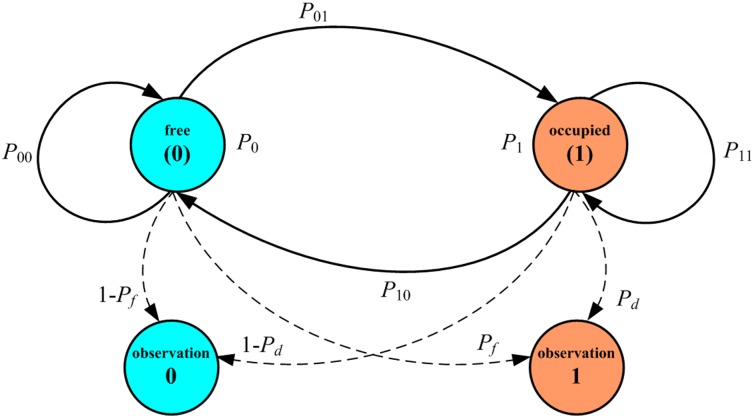
Channel state’s Markov model.